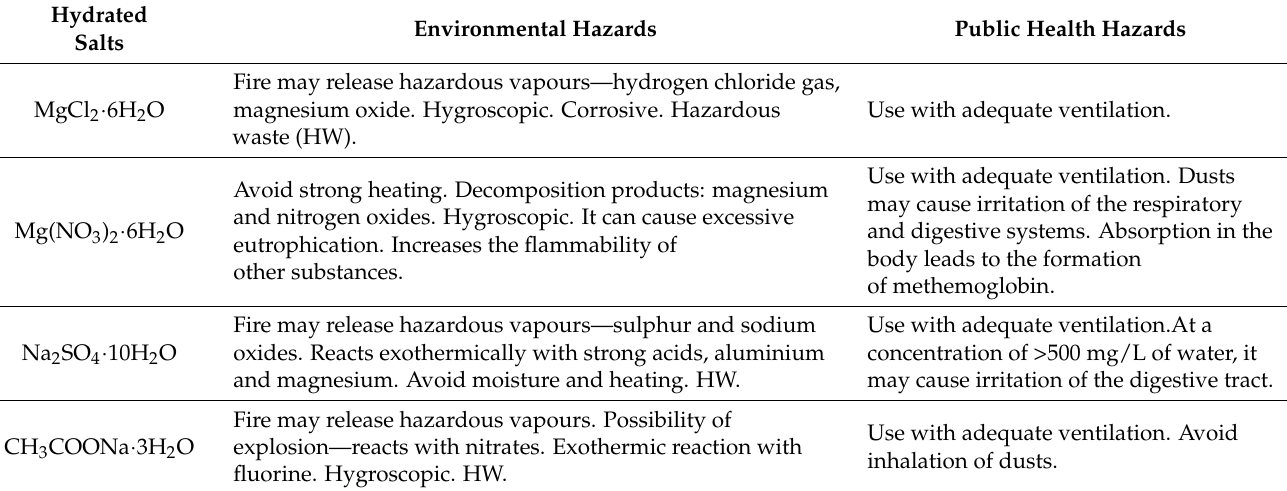
Table 2. The health and environmental concerns of the salt